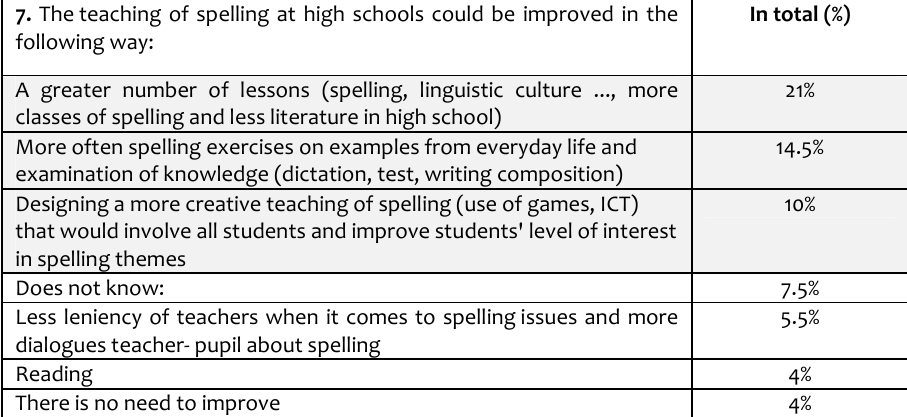
Table 8. Possibilities of improving the teaching of spelling from the perspective of high school